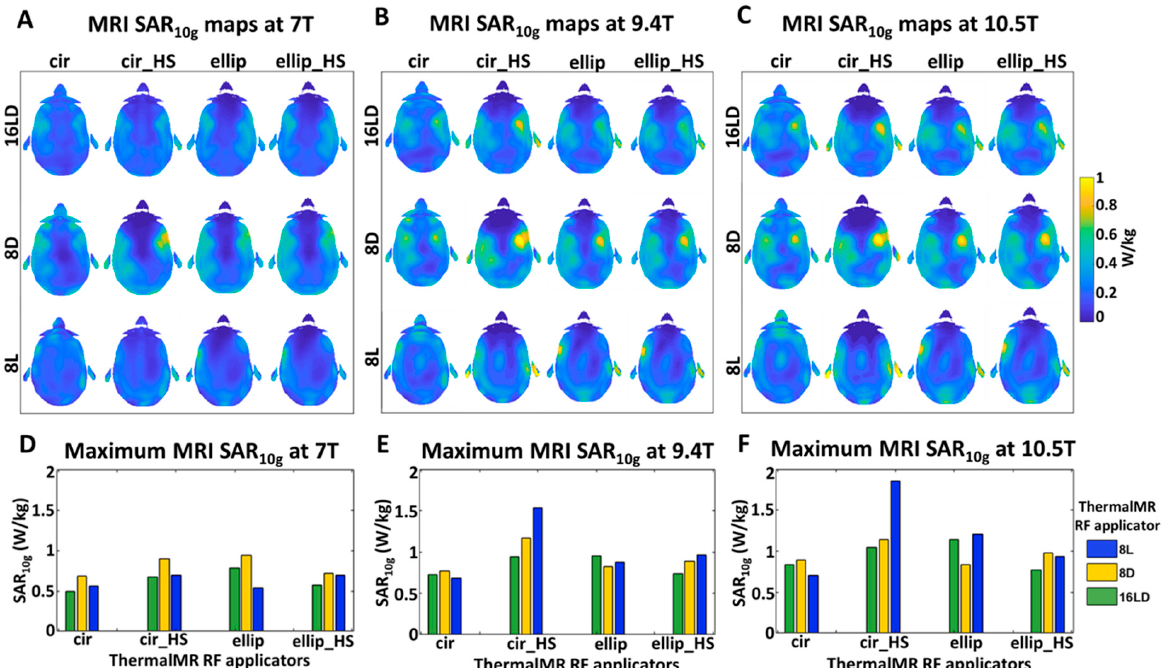
Figure 6. Maximum local SAR 10g does not exceed the IEC limits for all ThermalMR RF applicators for MR imaging. SAR 10g maps of the head of the human voxel model Duke (central axial slice) of ThermalMR RF applicators 16LD, 8D and 8L with cir, cir_HS, ellip, ellip_HS variants at magnetic field strength ( A ) 7.0 T, ( B ) 9.4 T, ( C ) 10.5 T. Quantification of maximum local SAR 10g at ( D ) 7.0 T, ( E ) 9.4 T, ( F ) 10.5